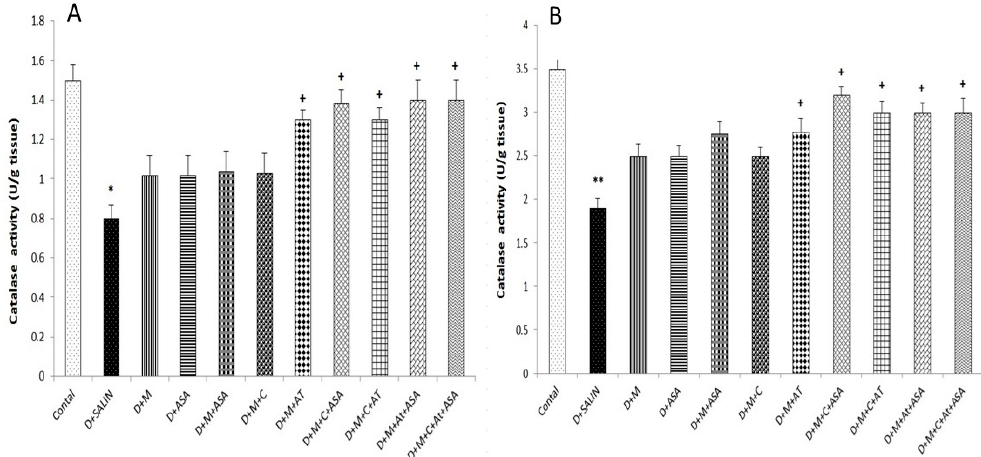
Figure 5. The catalase activity in the brain cortex ( A ) and hippocampus ( B ) tissues. Data were shown as mean ± SEM. * p < 0.05 and ** p < 0.01 compared to control and + p < 0.05 compared to diabetic group. D, diabetic; M, metformin; ASA, aspirin; AT, atorvastatin; and C, captopril.